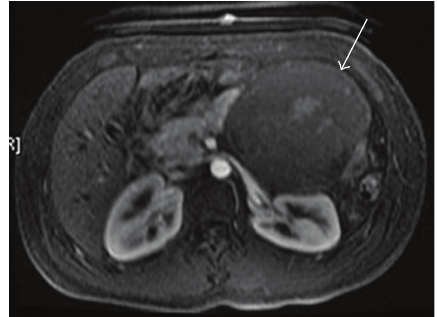
Figure 5: SPEN (arrow) with wall, internal septations and hemor- rhage on